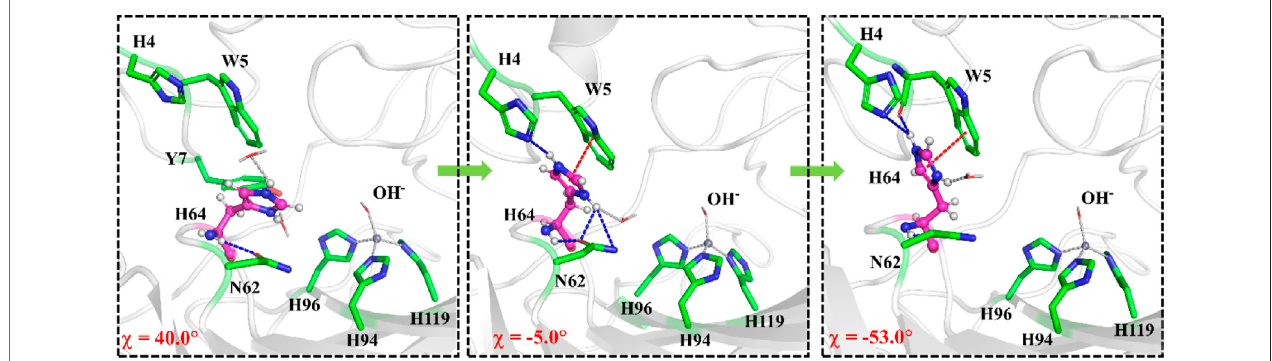
FIGURE 7 | Representative structures and conformational changes for the rotation of H64 from inward to outward conformation, where the reaction coordinate is de fi ned as the dihedral angle χ (N – C α – C β – C c ).